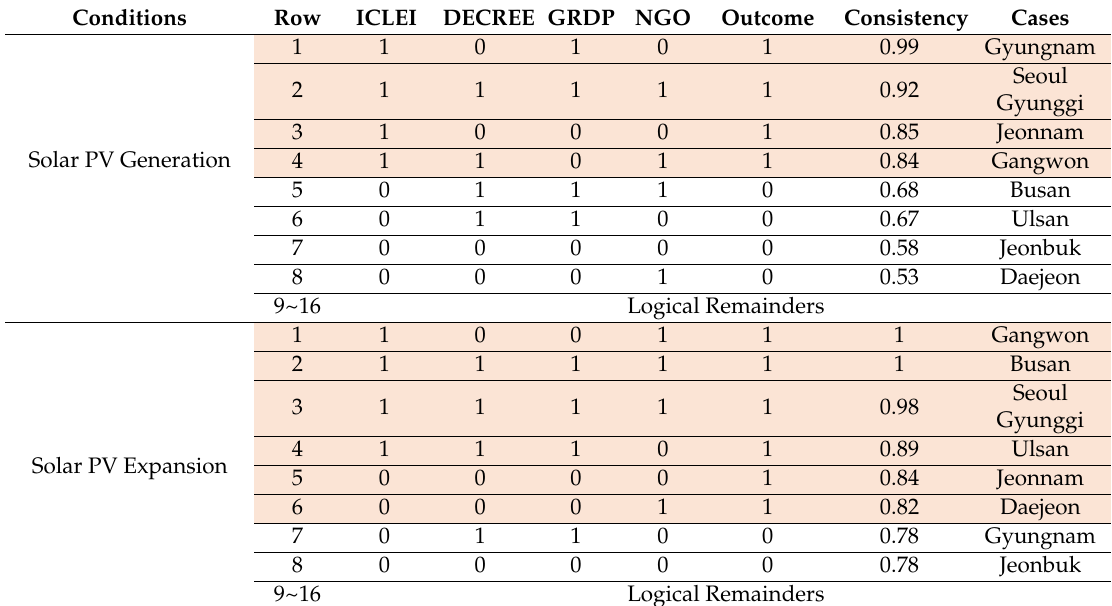
Table 3. Truth table of su ffi cient conditions for the outcome of solar PV generation.